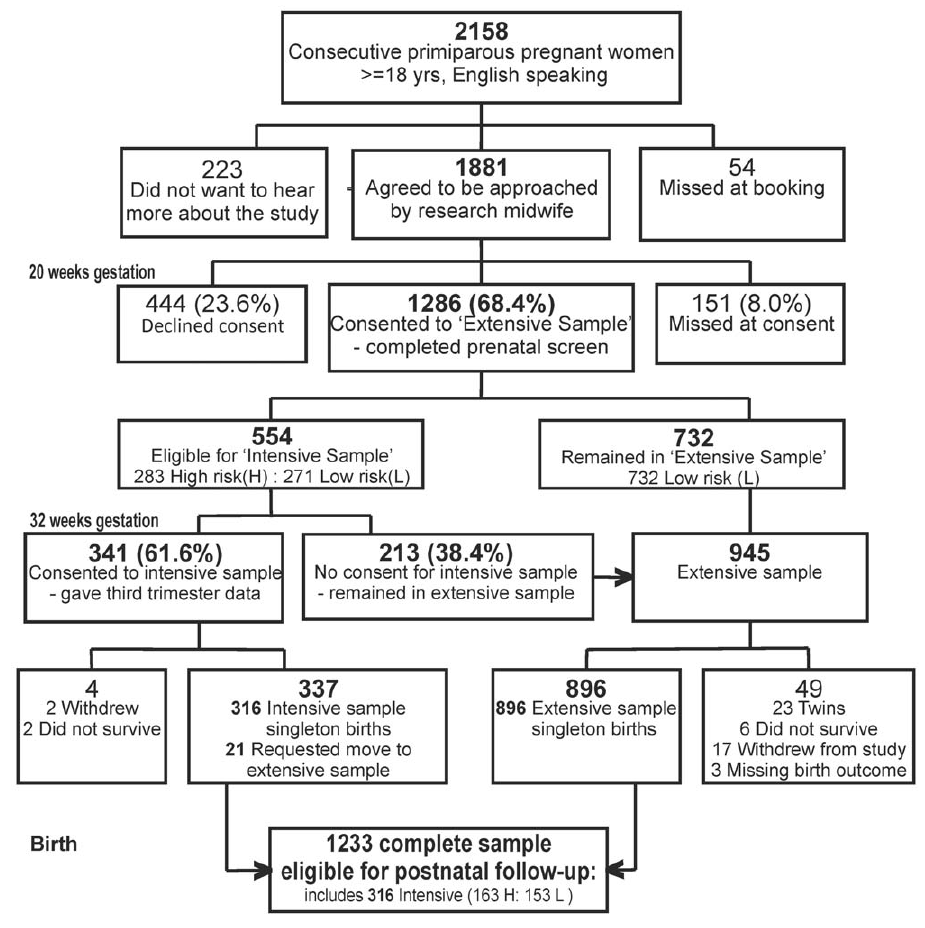
Figure 1. Sampling and recruitment.